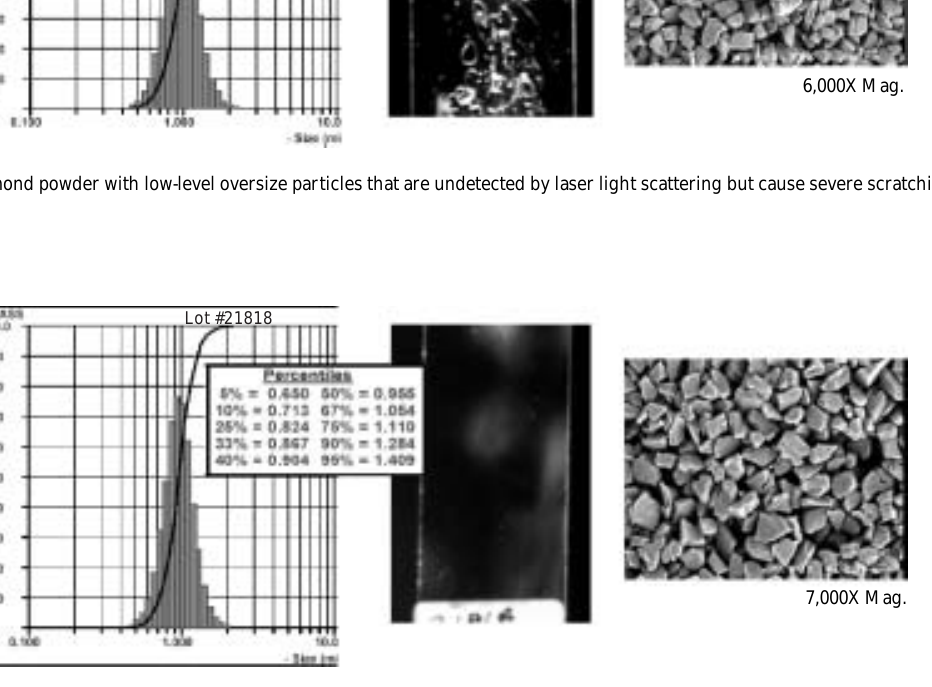
Fig. 5 Examples of 1 micron mean size powders having A.) low levels of oversize particles that are undetected using a laser light scattering technique, but clearly causing scratches in lapping application; and B.) powder of similar size distribution having no oversize particles present and producing uniform surface finish in a lapping application.